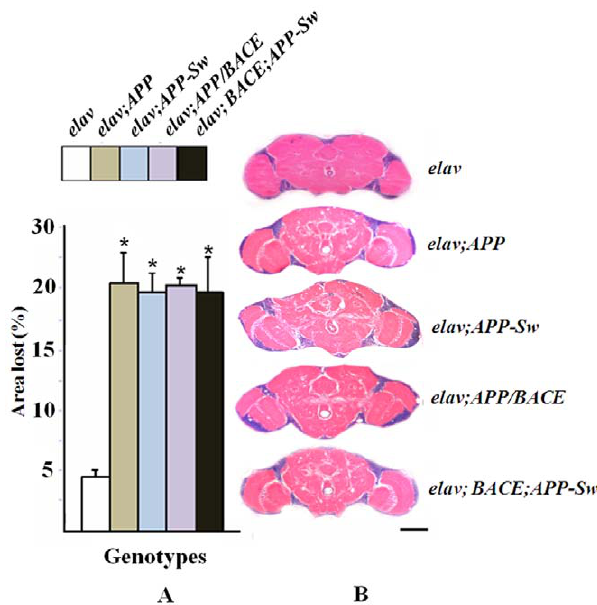
Figure 3. Age-dependent neurodegeneration in APP expressing transgenics. Microphotographs of the brains of 30-day-old flies; Bar, 50 m m. A ) Percentage of the area lost in the regions of the cell body and neuropil: The ratio of lost area was calculated by dividing the sum of the vacuole areas from all brain sections by the total area of the brain from all brain sections. We analyzed 6 brains for each genotype, 16–18 sections per brain. Percentage of the area lost is shown as averages 6 SEM. p , 0.05. B ) Neurodegeneration in APP flies at day 30. Paraffin slices were stained with hematoxylin and eosin and were examined under bright-field illumination using a Leica DM 2500 microscope at a magnification of 120X.